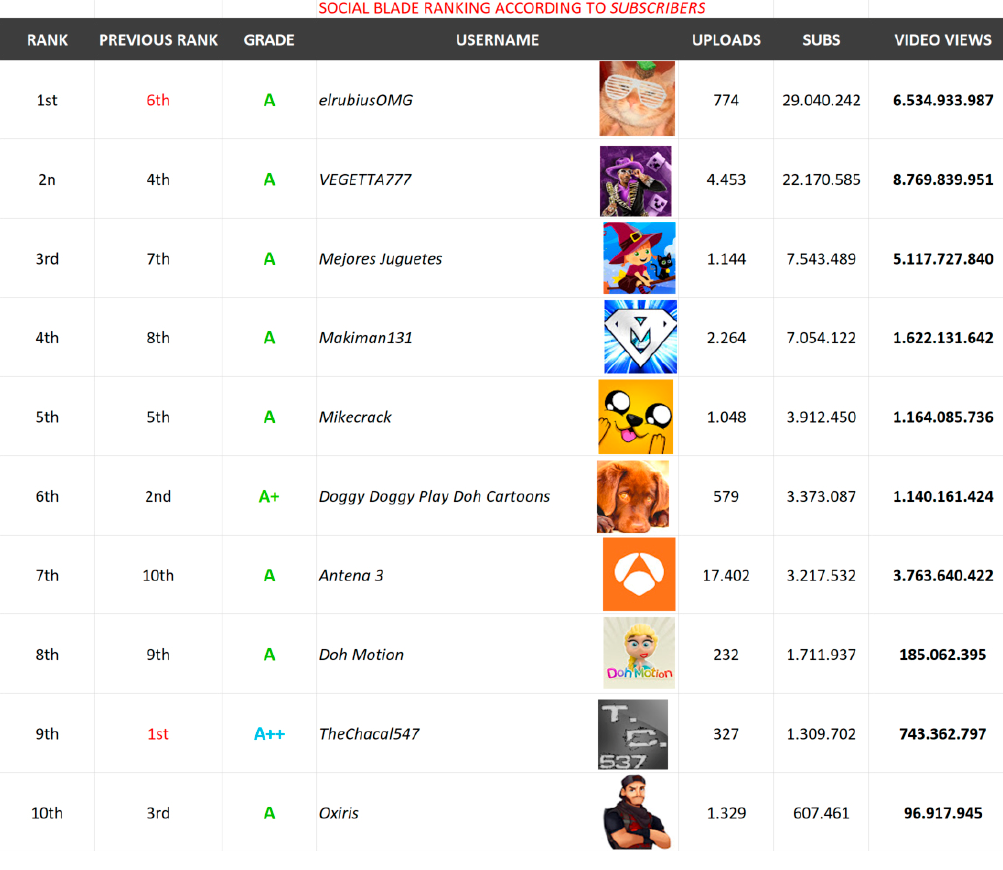
Figure 9. Social Blade ranking according to subscribers. Source: SocialBlade .com.